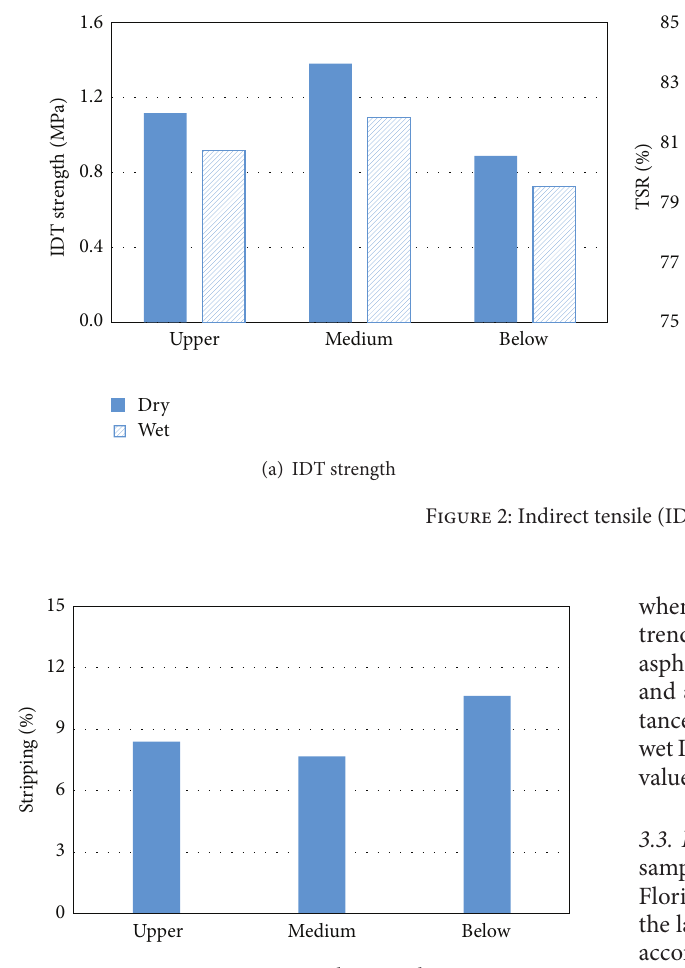
Figure 3: Image analysis